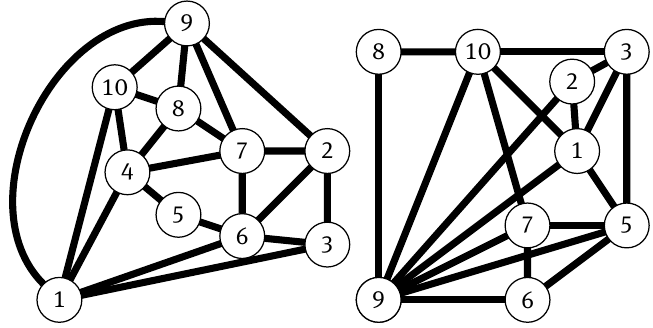
Figure 7: H 1 and H 2 , D L cospectral graphs where one is planar and one is not